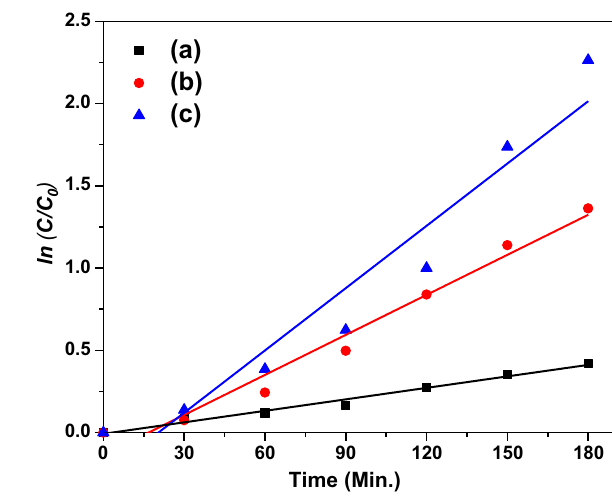
Fig. 8 Photocatalytic degradation of MO (a) SnO SnO 2 NPs and (c) 4% Zr-doped SnO 2 NPs